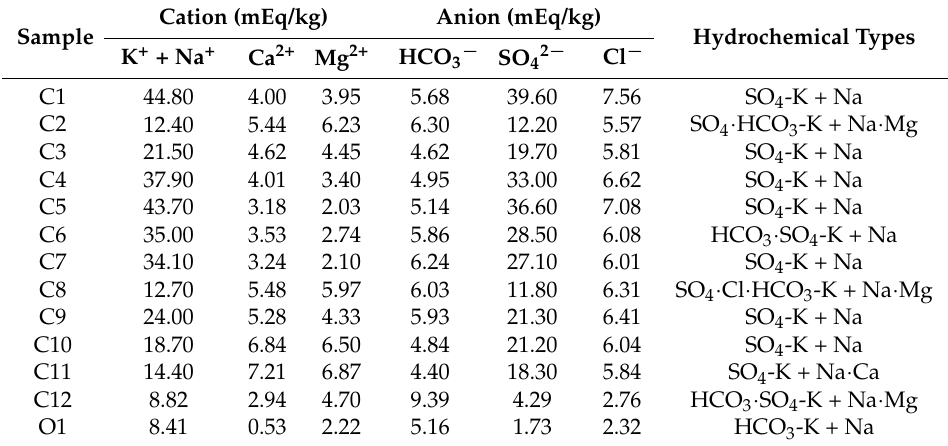
Table 3. Groundwater chemical ions milligram equivalent (mEq/kg) values and the hydrochemical types of all groundwater samples based on water quality analysis data.